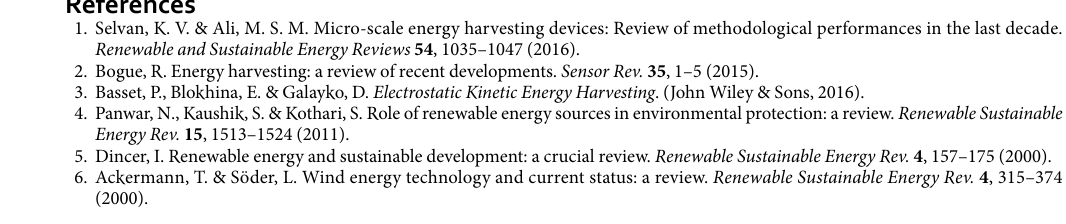
7 ScIENTIFIc REPORTS | 7: 17143 | DOI:10.1038/s41598-017-17453-4